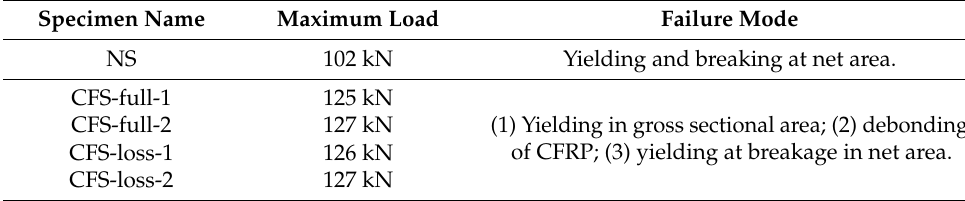
Figure 11. Experimental setup: ( a ) NS specimen; ( b ) CFS-loss specimen. Table 4. Maximum load and failure mode.